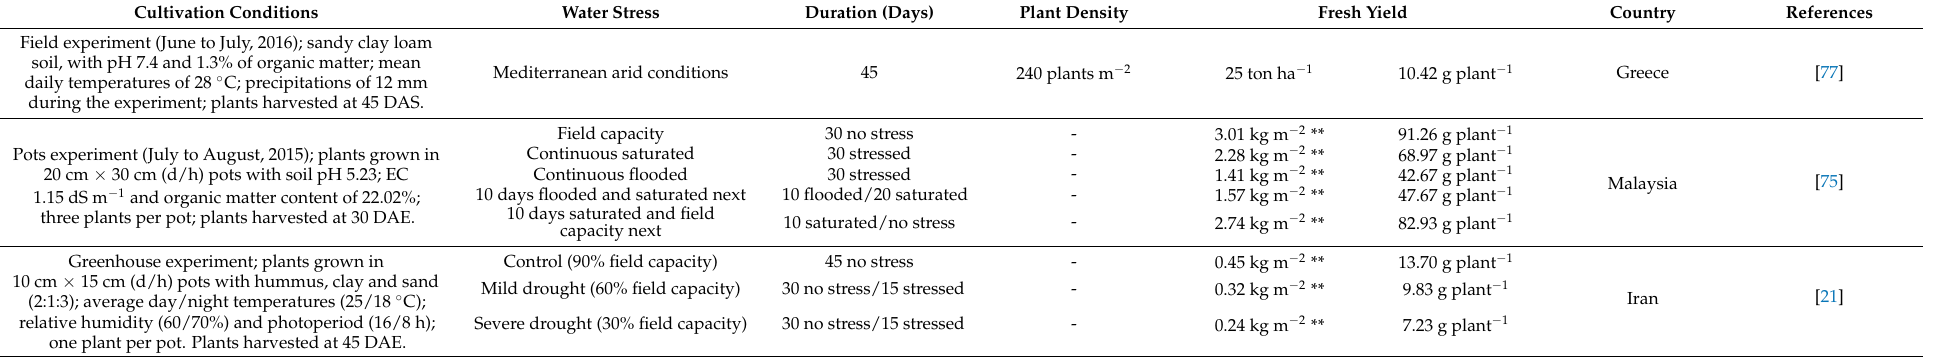
Table 1. Portulaca oleracea L. fresh yield under different water